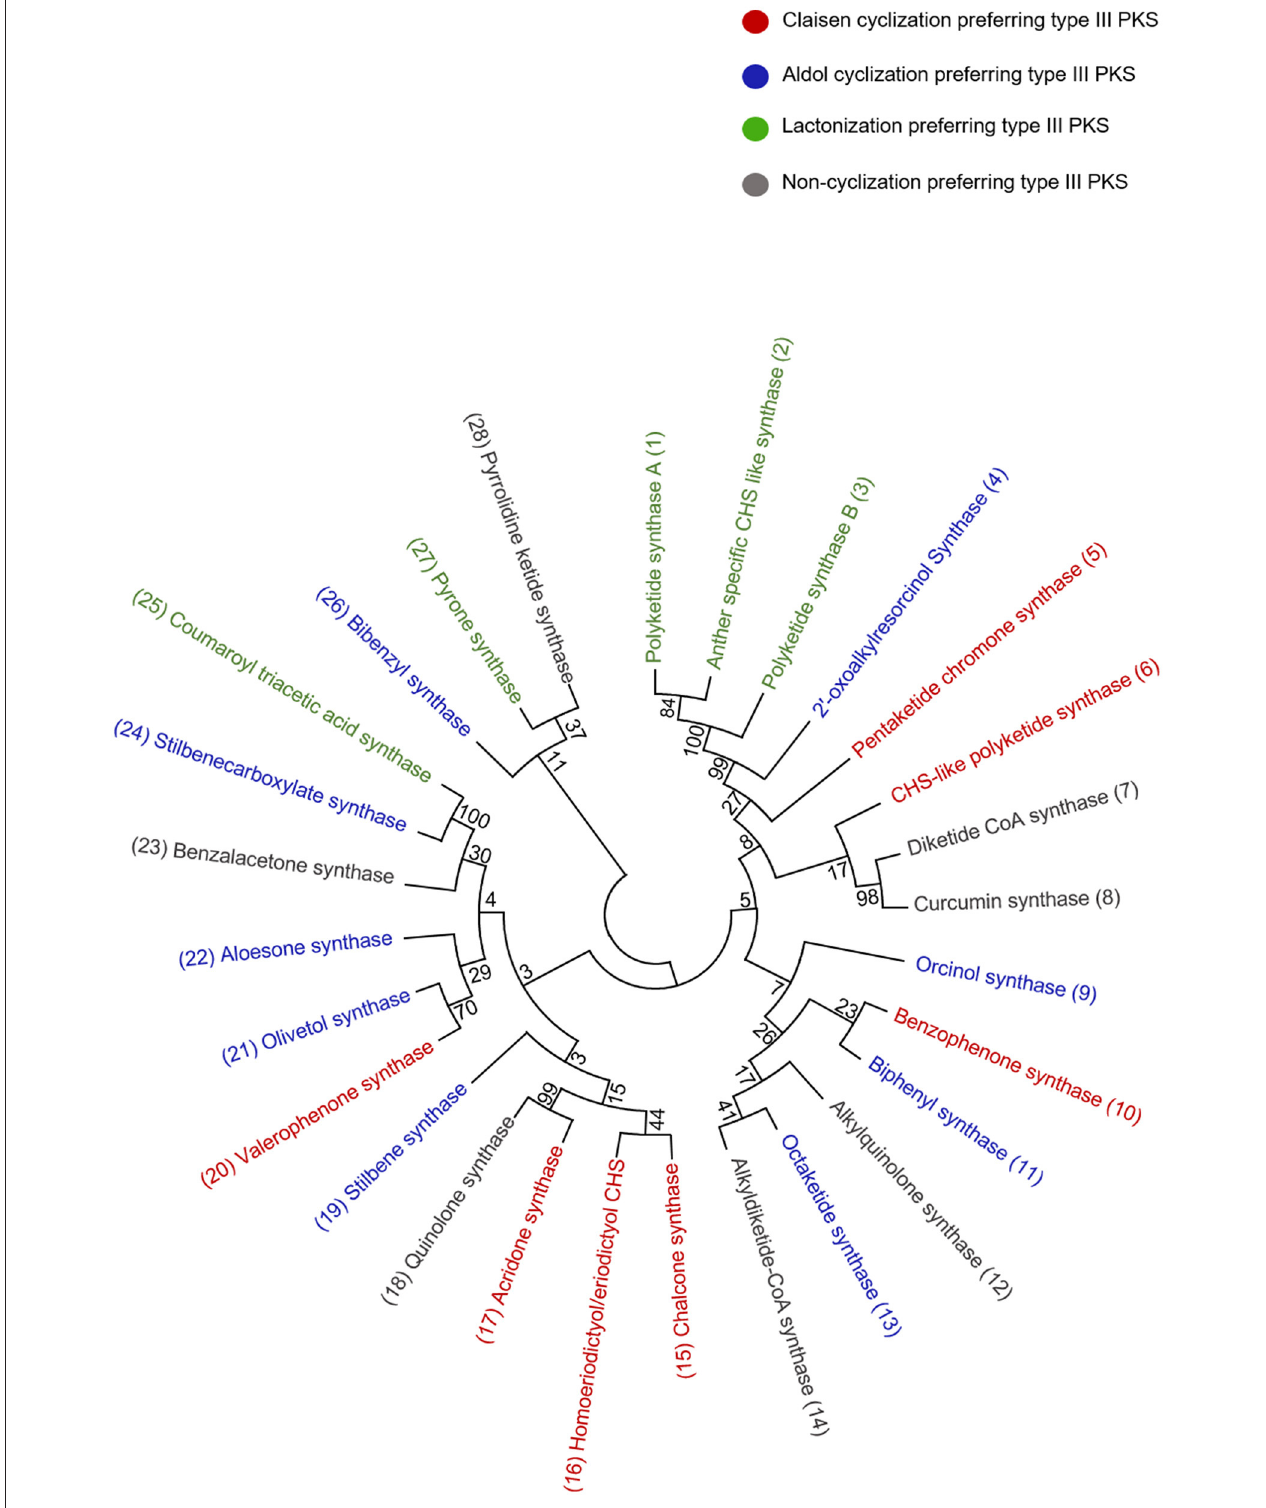
FIGURE 4 | Phylogenetic tree analysis of the representative type III PKSs from each cyclization class; the alignment was generated by CLUSTALW. The examples of each enzyme class are color-coded and the tree was constructed using the Maximum likelihood method by using 1,000 bootstraps.